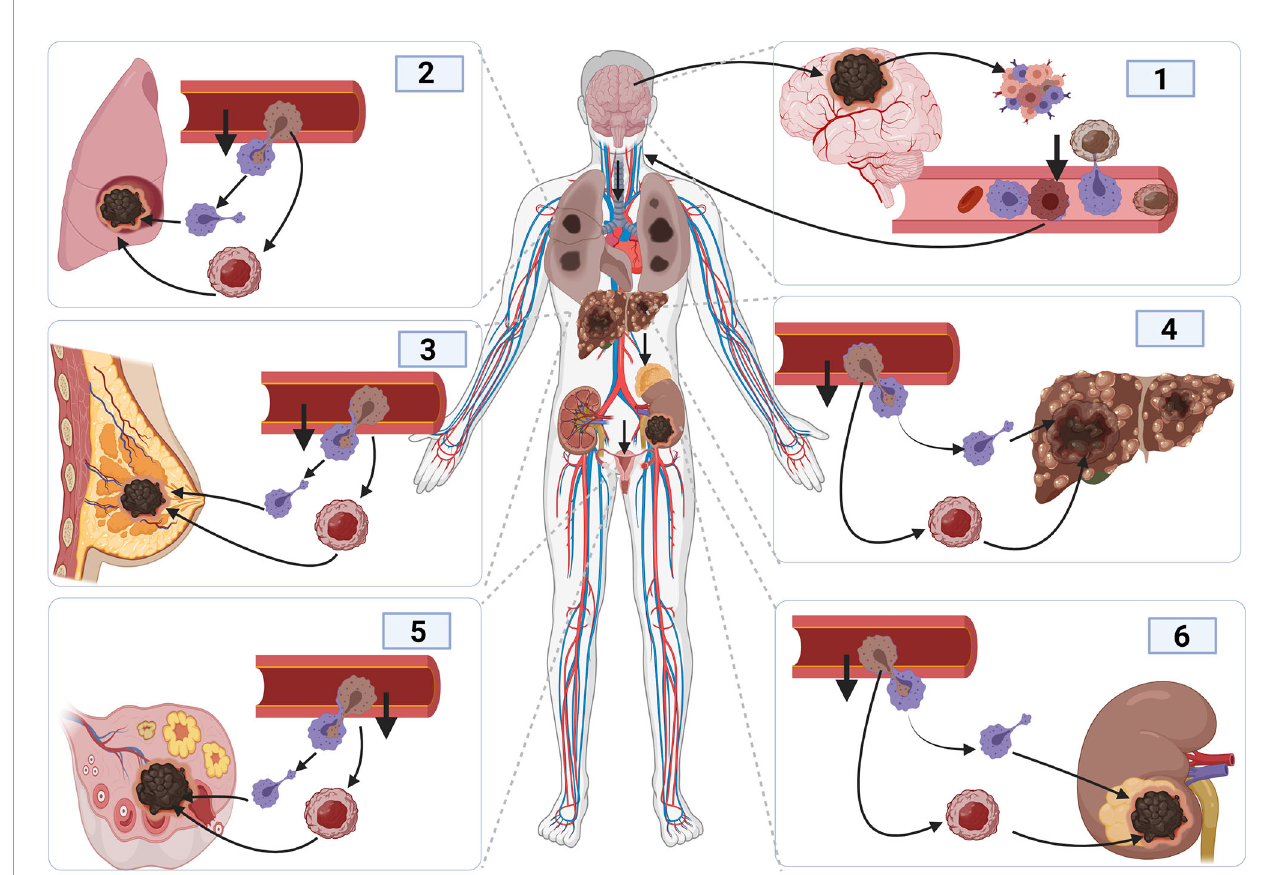
FIGURE 4 | Cancer metastasis mechanism and tumor initiation and spread in other organs. The initiation of brain cancer promotes angiogenesis and tumor development, causing in fl ammation. The development of in fl ammation promotes immune response. Cancer cells bind to activated macrophages crossing the blood vessels, facilitating their migration into the blood vessel, and entering the blood circulatory system to reach other organs using the same process used to enter inside blood